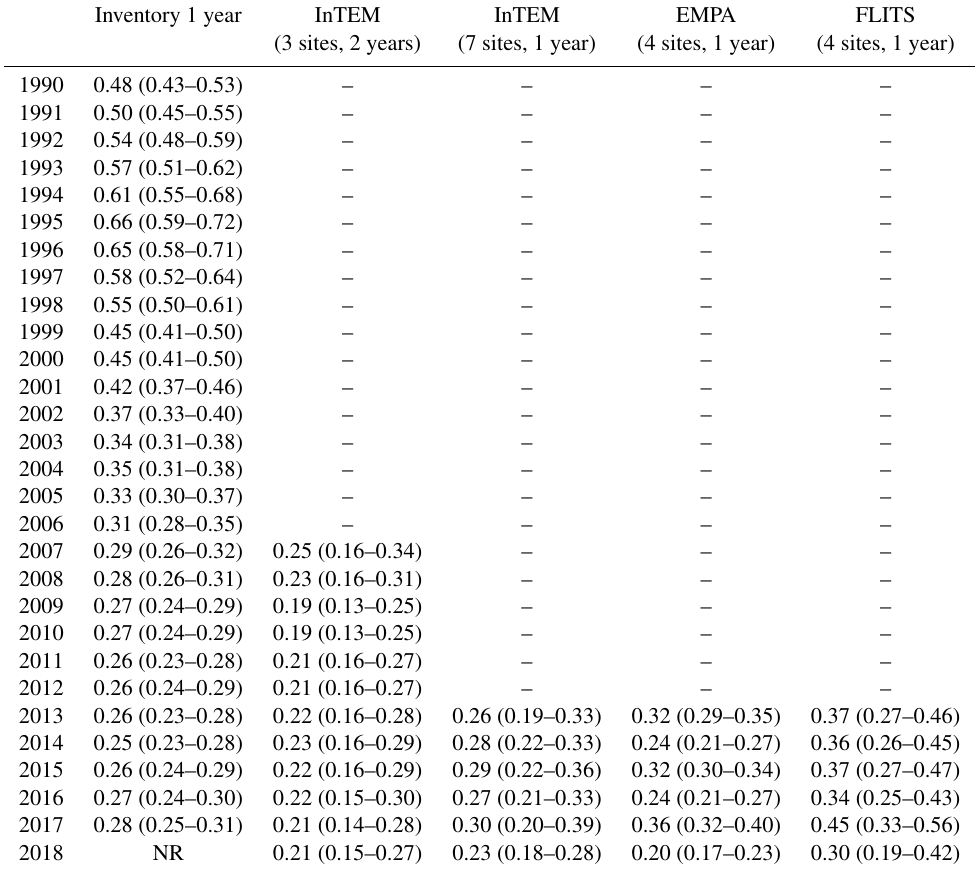
Table 6. SF 6 emission estimates for western Europe: UNFCCC inventory, InTEM, EMPA, and FLITS emissions (Ggyr − 1 ). (Uncertainties in